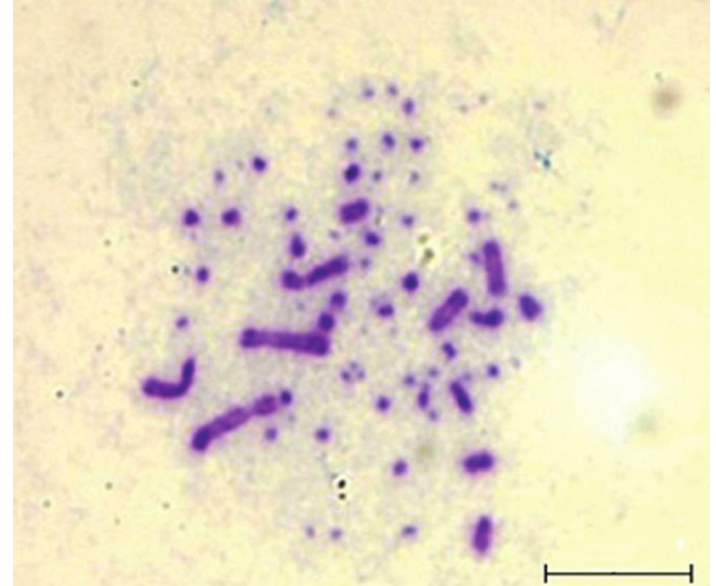
Figure 1. Metaphase of the Houbara bustard showing macrochromosomes and microchromosomes with Giemsa staining. Scale bar: 5 μm.